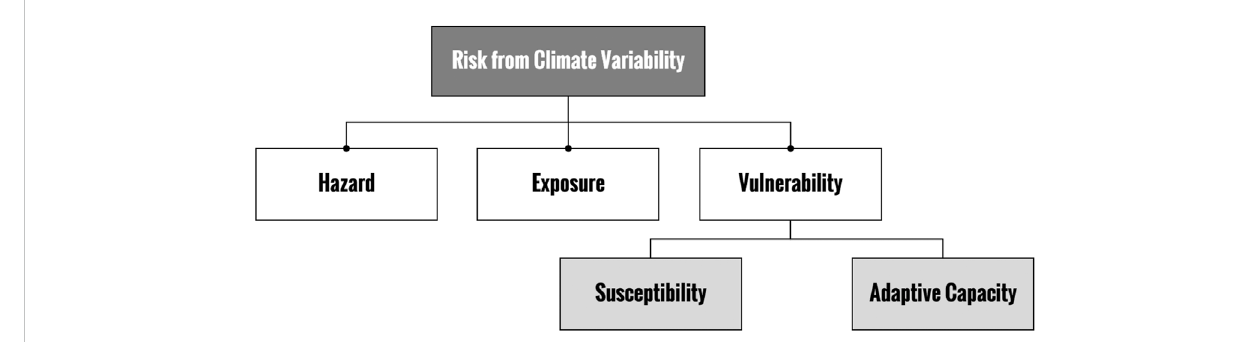
FIGURE 1 Relationship between exposure, susceptibility, and adaptive capacity in formulating